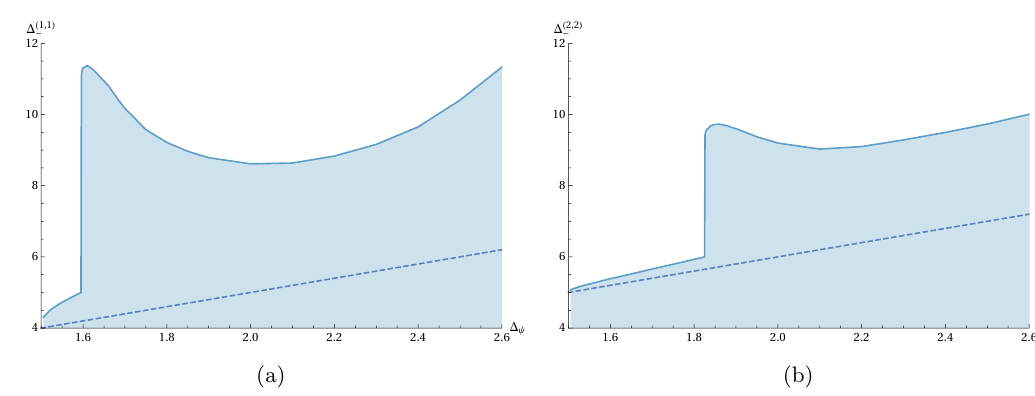
Figure 10 . Left: upper bound on the dimension of the (cid:12)rst charged (1 ; 1) operator. Right: upper bound on the dimension of the (cid:12)rst charged (2 ; 2) operator. The shaded region is the allowed one. The bounds have been computed at (cid:3) = 16. The dashed lines represent the